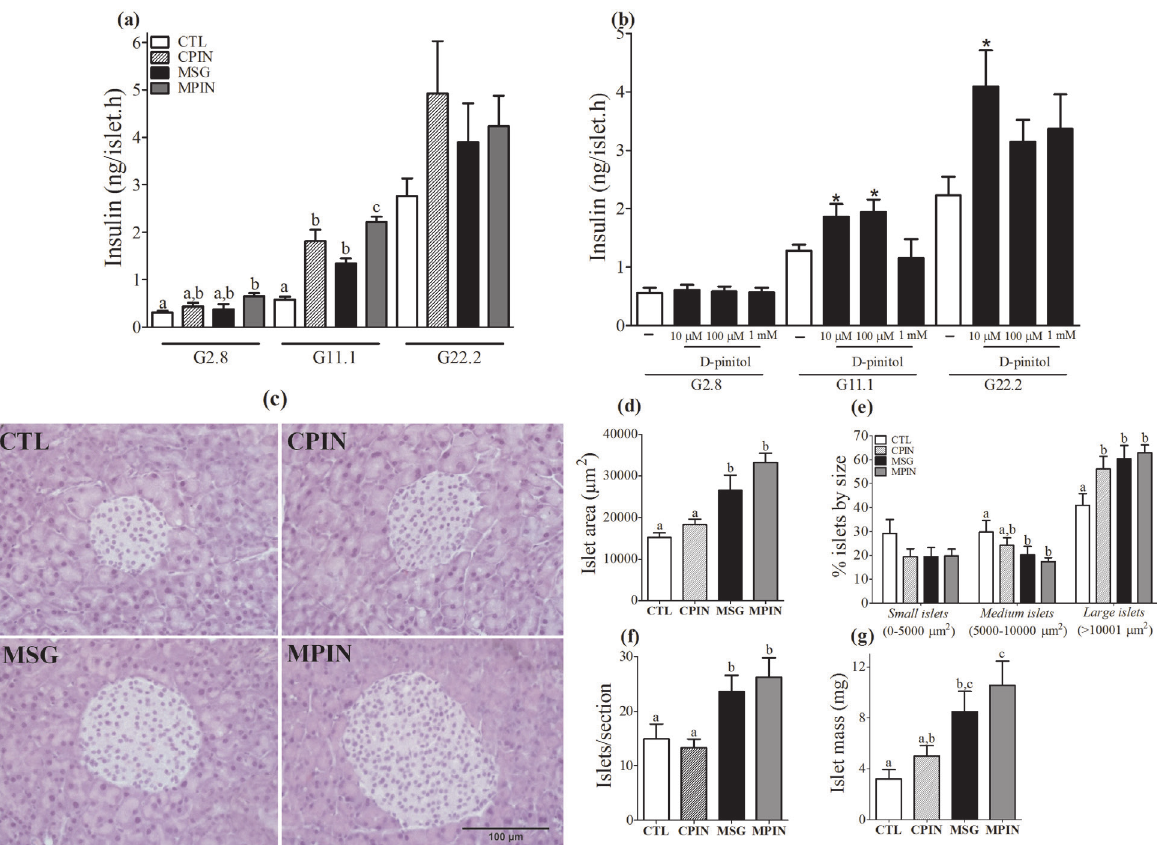
Figure 4. D-pinitol treatment increases glucose-induced insulin secretion in both, MSG and CTL mice, possibly due to a direct insulinotropic action on pancreatic β-cells. (a) Static insulin secretion in response to 2.8, 11.1 or 22.2 mM glucose (G) in islets isolated from CTL, CPIN, MSG and MPIN mice. (b) Insulin secretion of islets isolated from the CTL mice incubated with 2.8, 11.1 or 22.2 mM G without or with 10 μM, 100 μM or 1 mM D-pinitol. Groups of 4 islets of similar sizes were incubated for 1h under the different G or D-pinitol concentrations as indicated in figures a and b. Each bar represents means ± SEM of 10 groups of islets in three independent experiments from islets isolated from 3 mice for each experimental group. Different letters over the bars represent significant differences between the groups at the same G concentration evaluated (Kruskal-Wallis followed by Dunns post-test; P < 0.05). (c) Panels show representative images from 5-µm sections of pancreases, stained with hematoxylin and eosin, from CTL, CPIN, MSG and MPIN mice. Scale Bar = 100 µm. Means ± SEM of islet area (d), the percentage of distribution of islets by size (e), number of islets per pancreatic section (f) and islet mass (g) in the pancreases of CTL (n = 5), CPIN (n = 5), MSG (n = 5) and MPIN (n = 5) mice. Endocrine pancreatic morphological analyzes were performed in 3 sections from each pancreas collected. Different letters over the bars represent significant differences (Kruskal-Wallis followed by Dunns post-test, P <